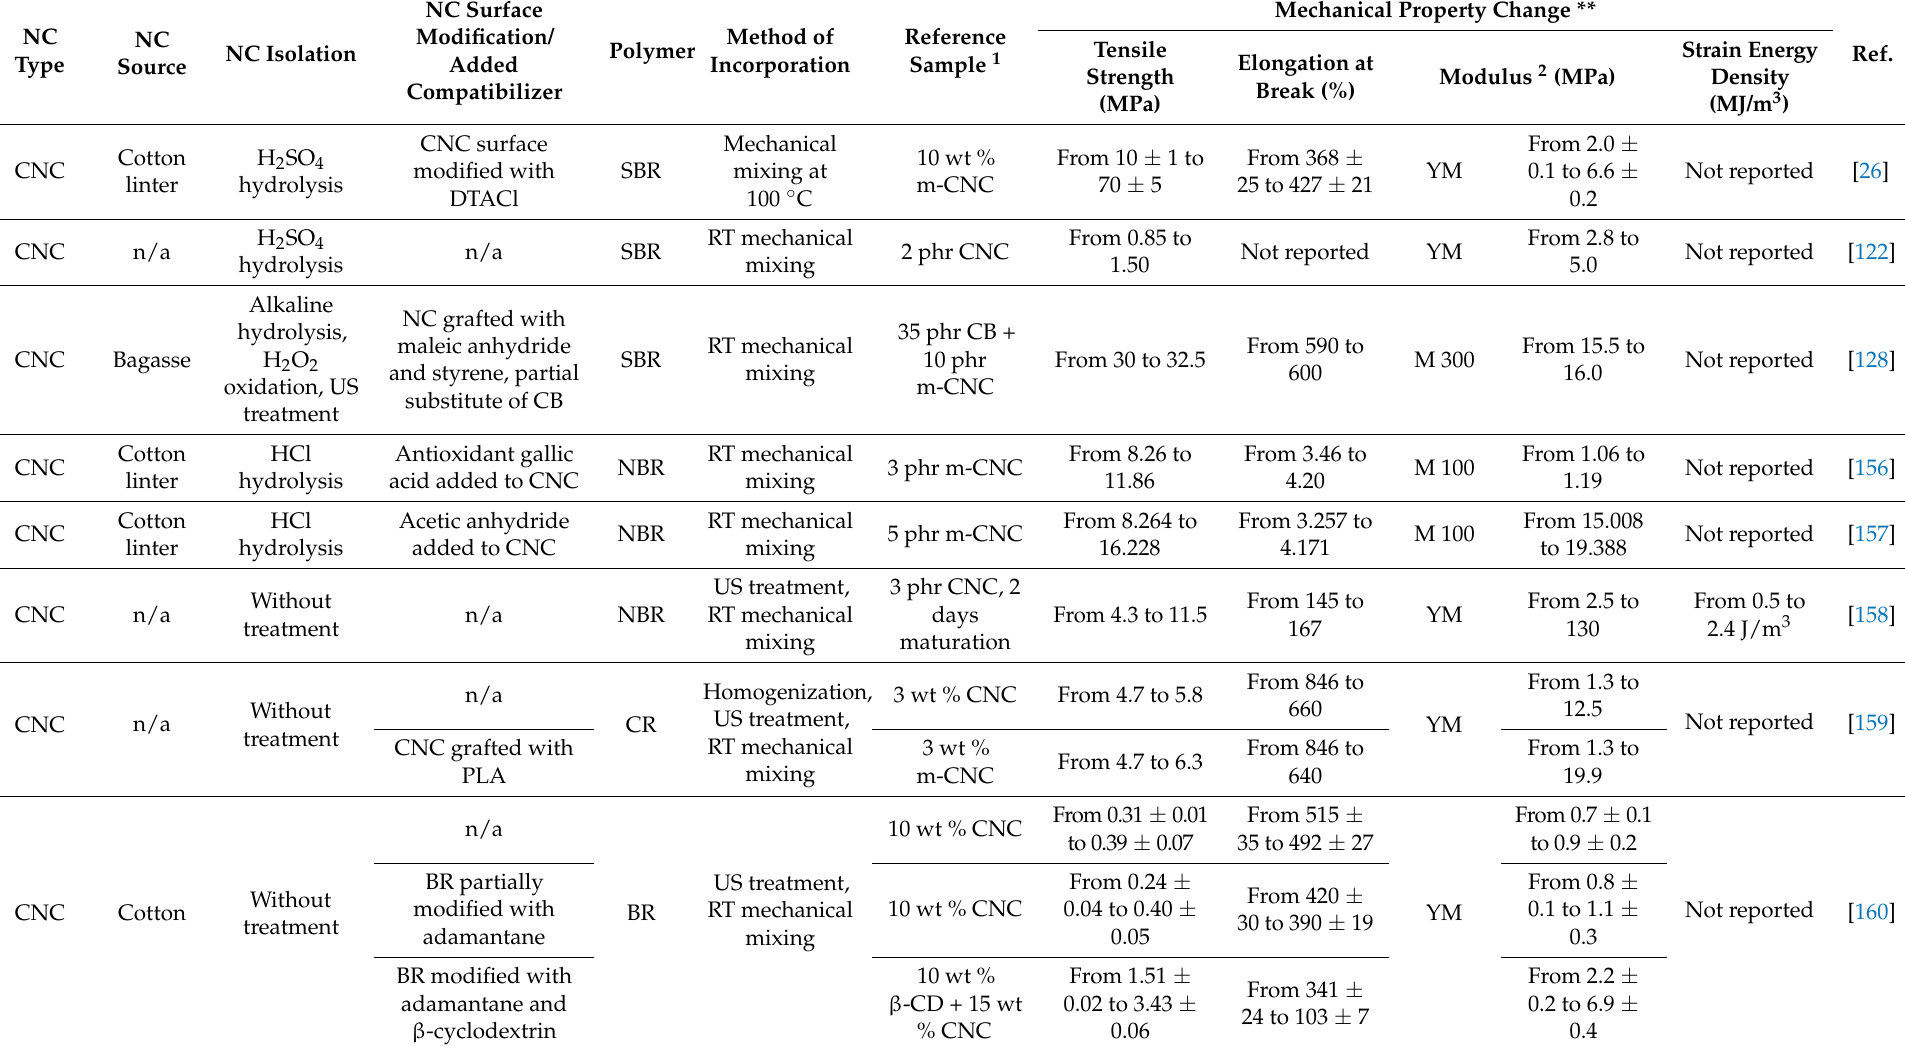
Table 5. Recent reports on NC-reinforced synthetic rubber